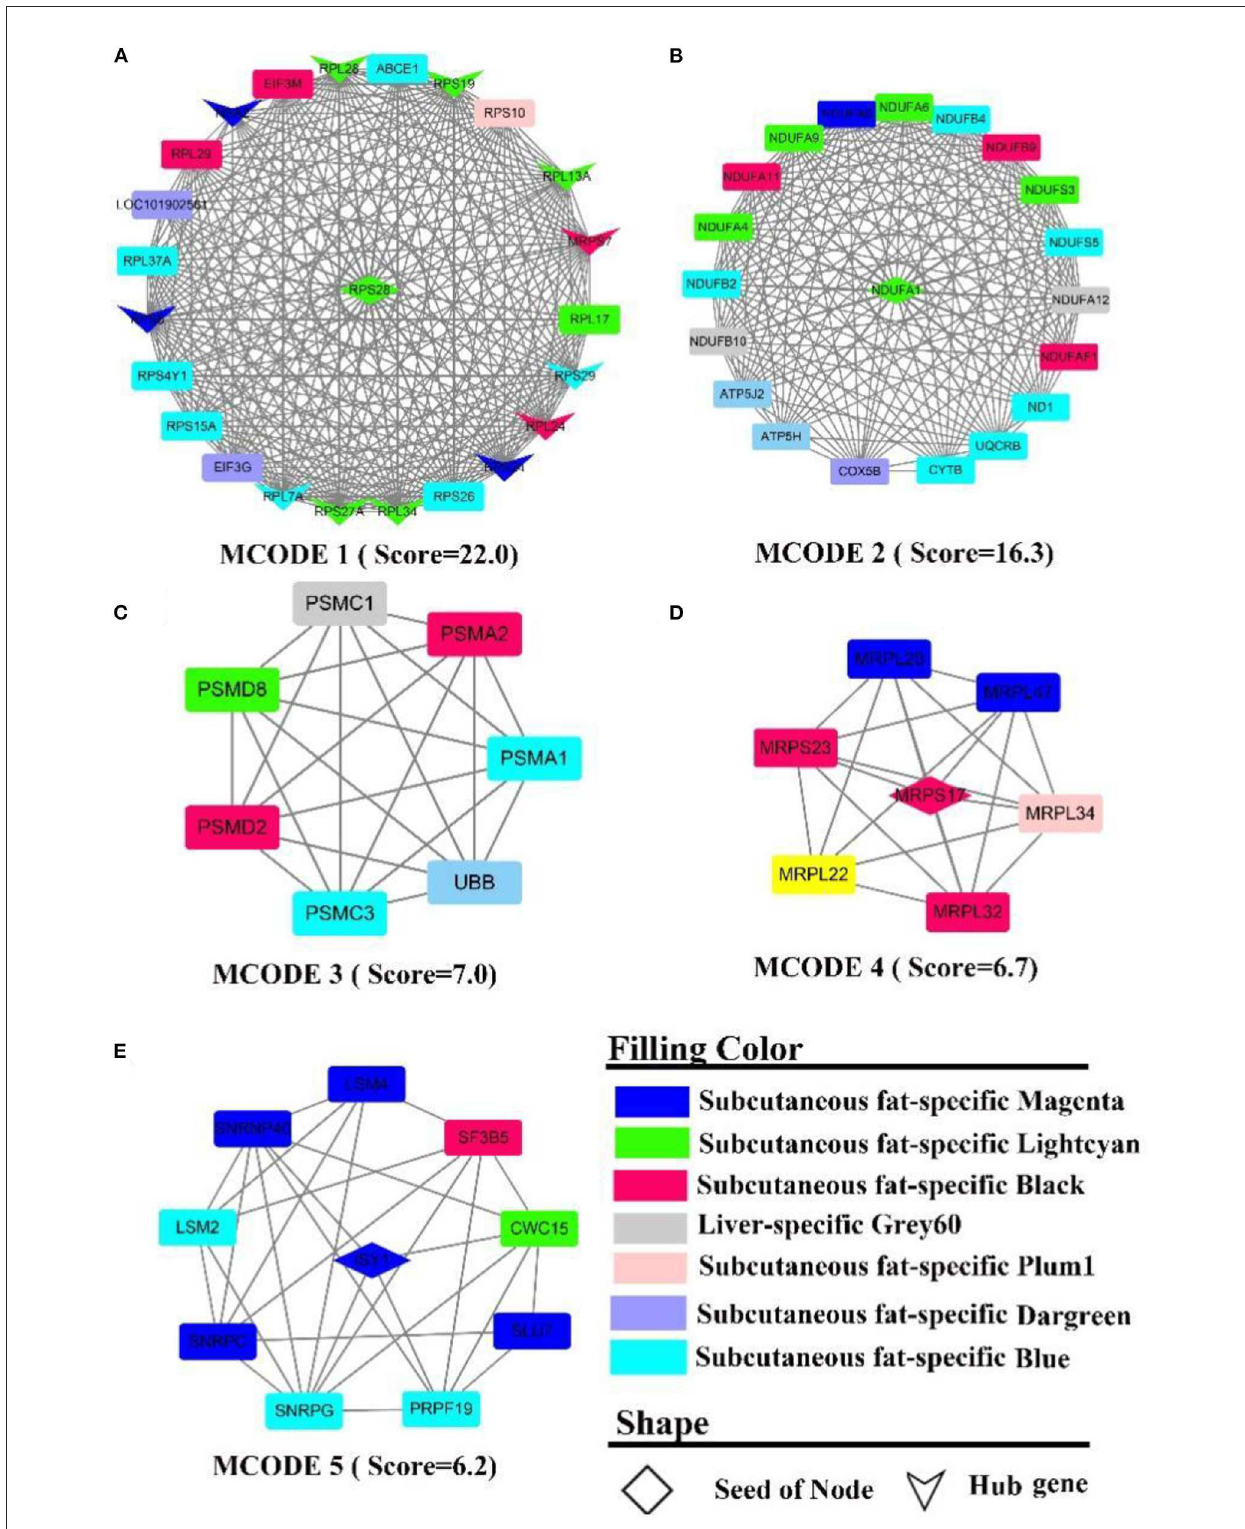
FIGURE7 PPI and hub gene analysis for genes in LF regulatory axis. The color and shape represented gene source and gene type, respectively.